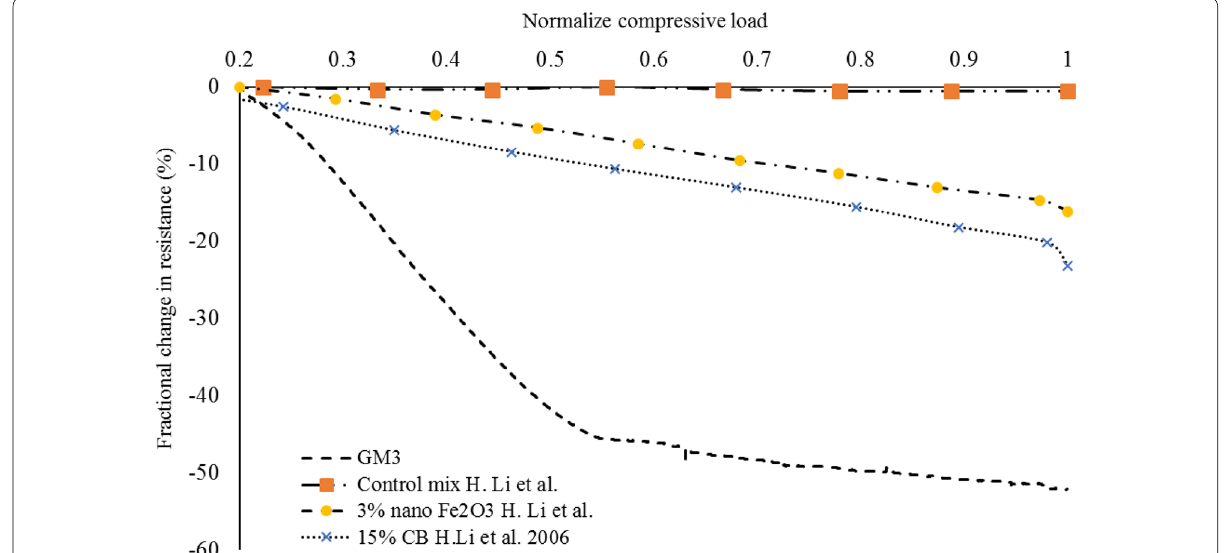
Fig. 8 Fractional change in resistance against normalized compression load for GM3 specimen, 3% nano Fe 2 O 3 by Li et al. (2004) and 15% carbon Black (CB) by Li et al.